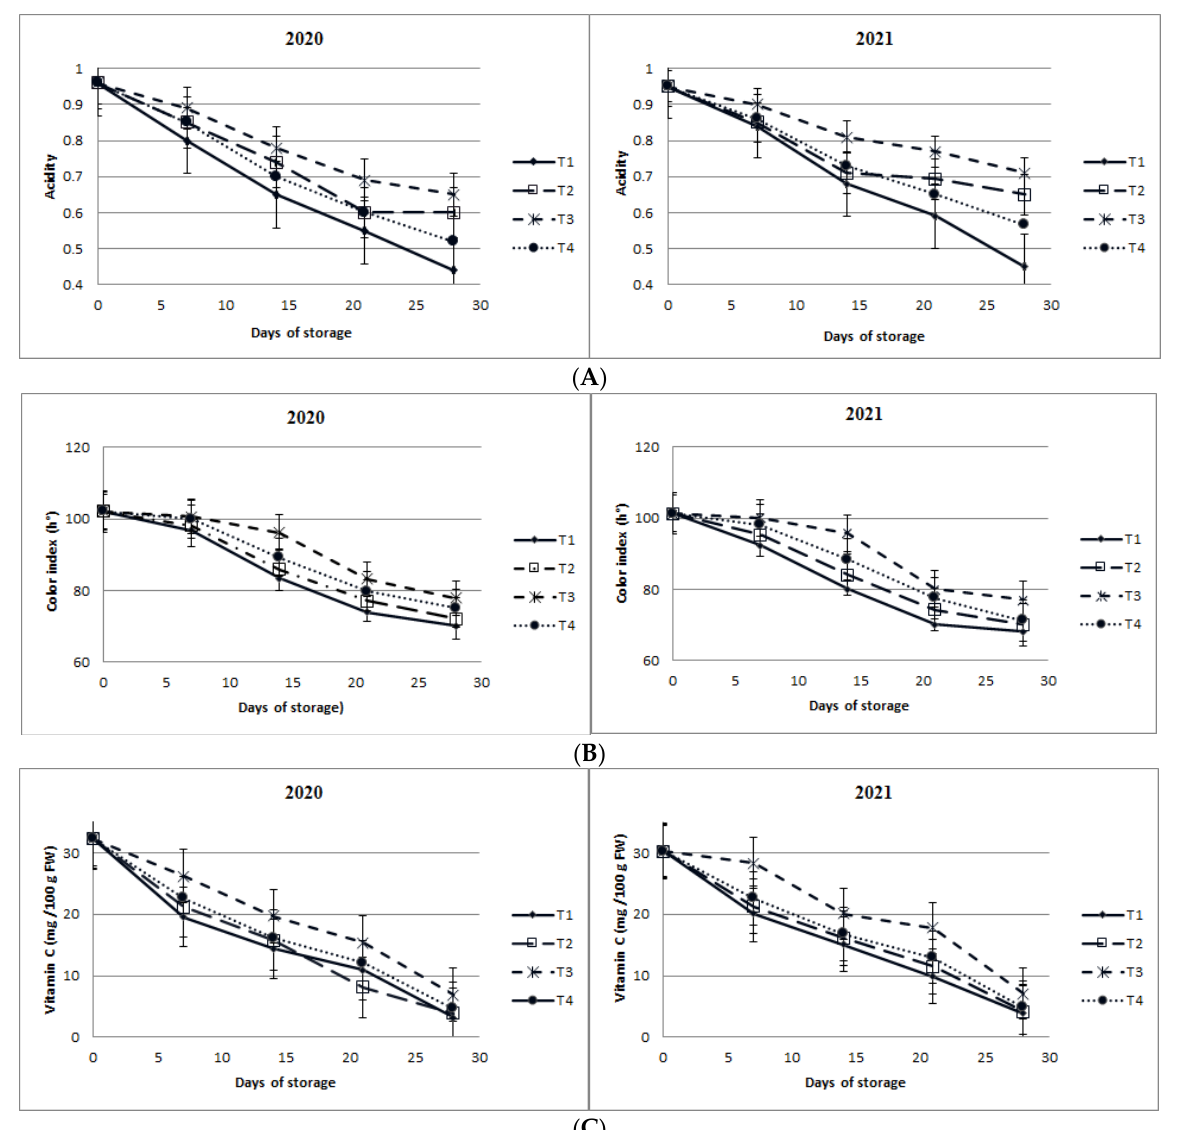
Figure 3. Effect of hot water treatment and chitosan coating on acidity ( A ), color index ( B ), and vitamin C ( C ) of mango fruits during storage at 13 ± 0.5 °C and 85–90% relative humidity (RH) for 28 days during 2020 and 2021 seasons. Values are means ± SE from three replicates. Statistical analysis was performed using LSD test.